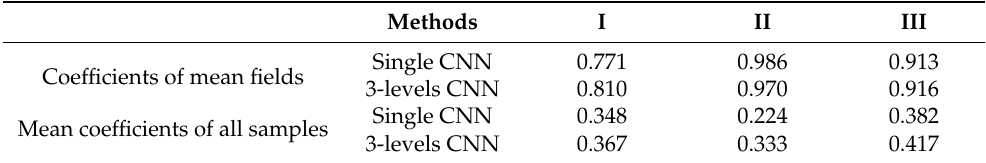
Table 2. The correlation coefficients between the transfer learning CNN model and the heavy rainfall of typical mode patterns in